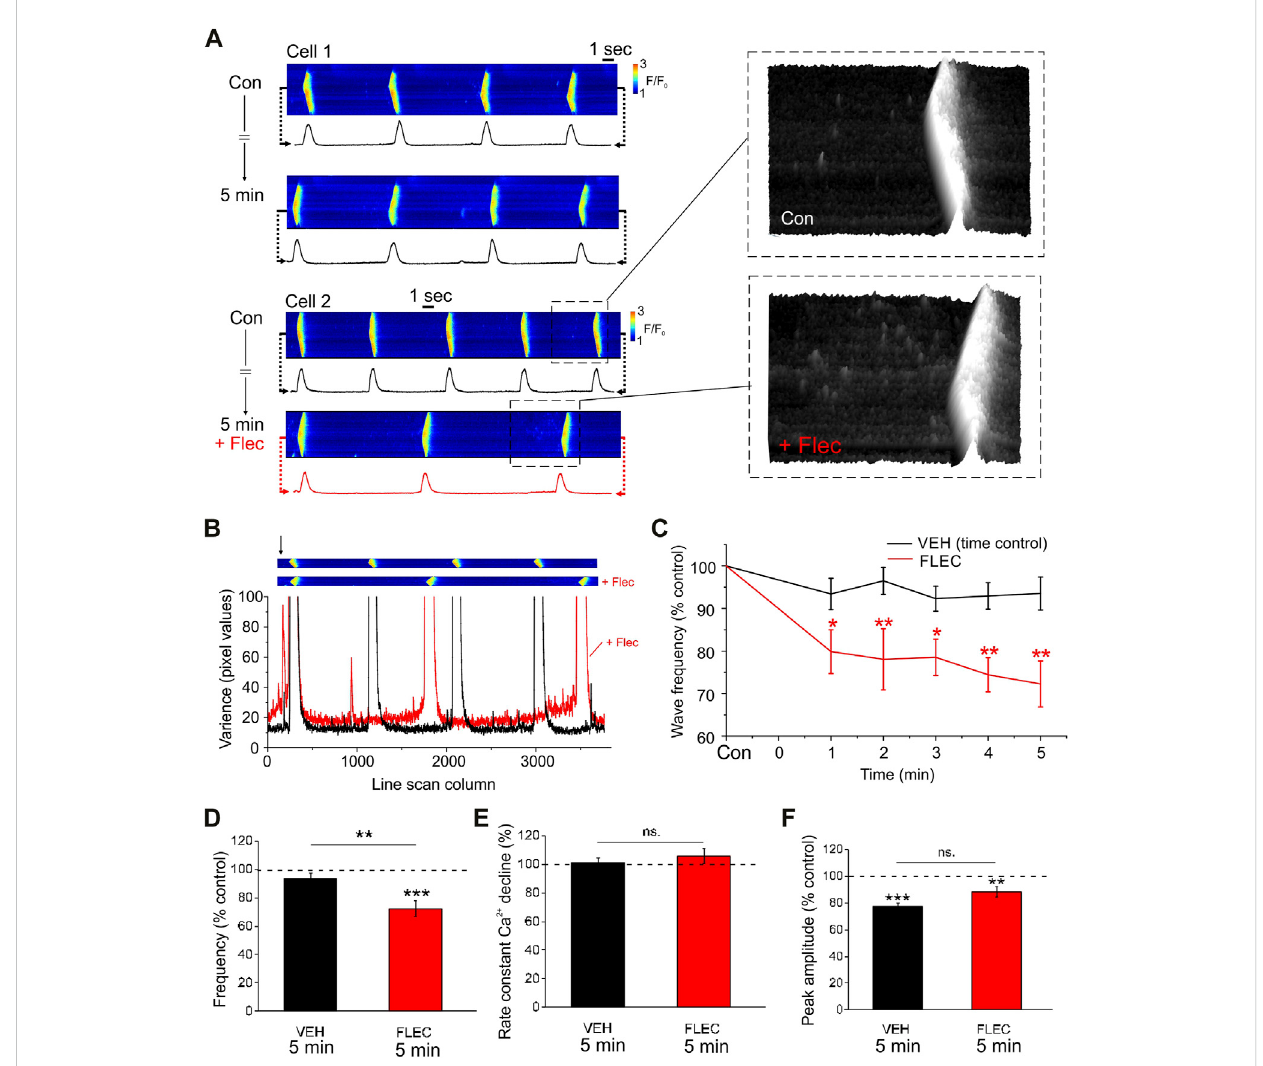
FIGURE 1 Flecainide decreases Ca 2+ wave frequency in permeabilized ARVM (A) , Representative line scans of cells and corresponding line pro fi les under control conditions (Con) and after 5 min incubation with either vehicle( upper ) or 25 µM fl ecainide ( lower ). Enlarged high contrast regions show changes in spark frequency during the period just before each wave. (B) , Line scan images before and after addition of fl ecainide ( upper ) and corresponding plot showing the variance of each column ( arrow ) of pixel values before (black) and after (red) exposure to fl ecainide. (C) , Percentage change in wave frequencyasafunctionoftime. (D – F) ,Percentagechangeexpressedrelativetotimezerocontrol(dottedline) , wavefrequency,thetimeconstantforthe decrease in[Ca 2+ ]and waveamplitude. RepeatedmeasuresANOVAwith Holm-Sidak posthoc testorpairedor unpaired Student ’ st-tests as